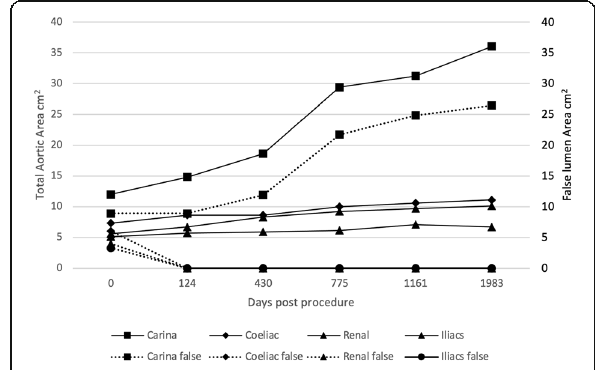
Fig. 8 Total and false luminal aortic area (cm 2 ) in one patient with progressive endoleak